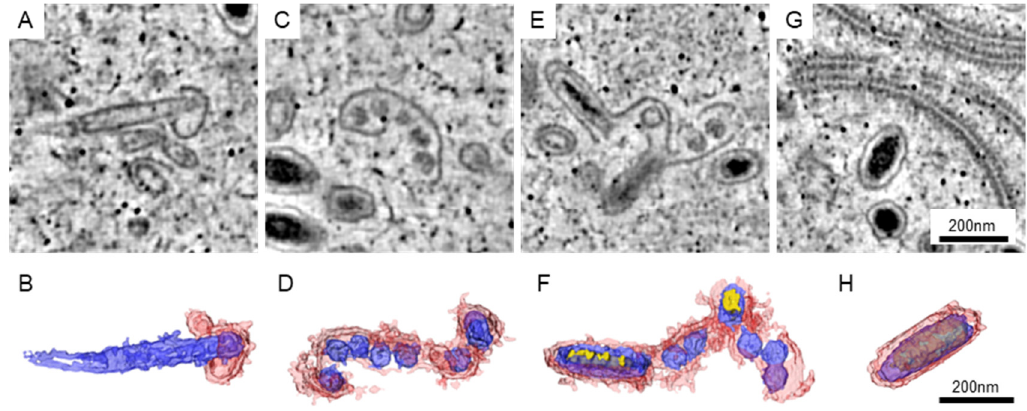
Figure 3. The immature particles in the WSSV-infected nucleus. The represented images of imma- ture ( A , C , E ) and matured ( G ) particles in the tomograms are shown. ( B , D , F , H ) The 3D structure of the particles in ( A , C , E , G , respectively). Red: the membrane-like structure presumed to be envelopes. Blue: the core units presumed to be the nucleocapsid and tegument. Yellow: the electron-dense ma- terials presumed to be genetic materials.